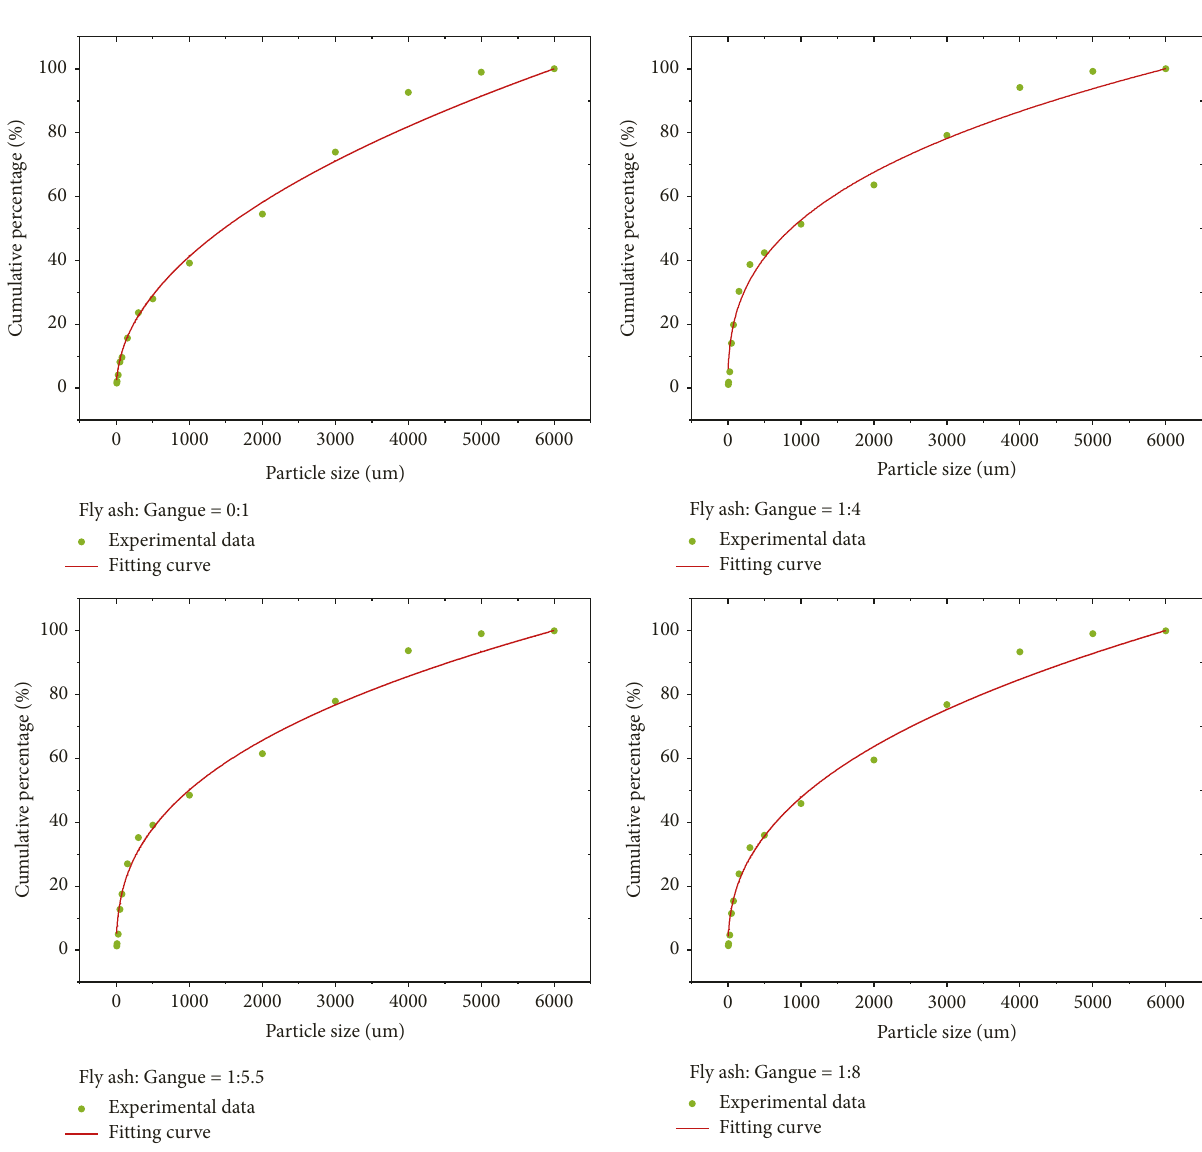
Figure 3: Particle size distribution and fitting of mixed materials. Table 3: Fractal dimension and correlation coefficient.